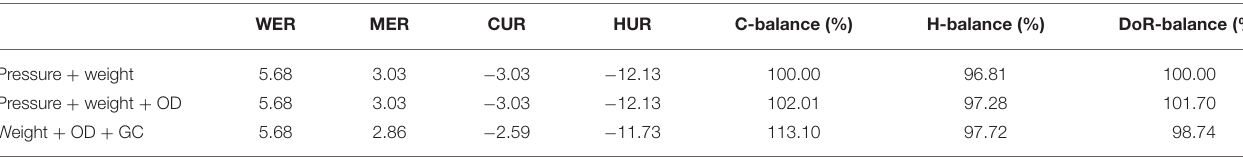
TABLE 5 | Comparison of the volumetric uptake and production rates and mass balances for the three methods for M. villosus DSM 22612 (OD). WER